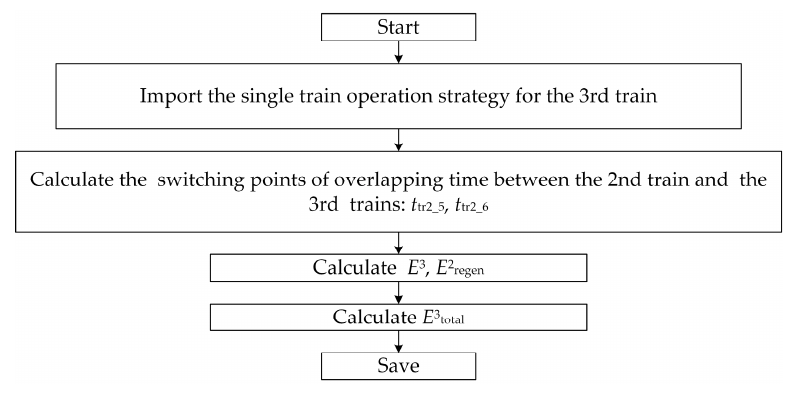
Figure 10. The calculation process of the 3rd train under four-mode operation.